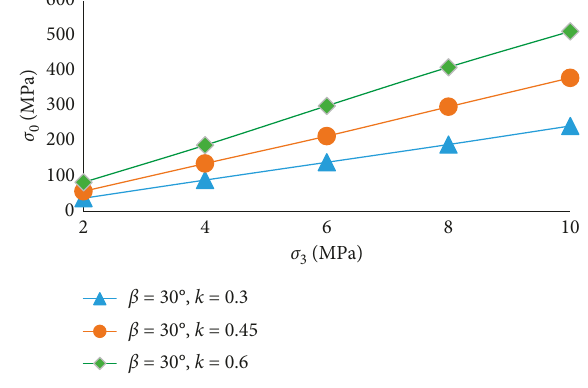
Figure 9: The stress extremum with 30 ° joint angle under different confining pressures.